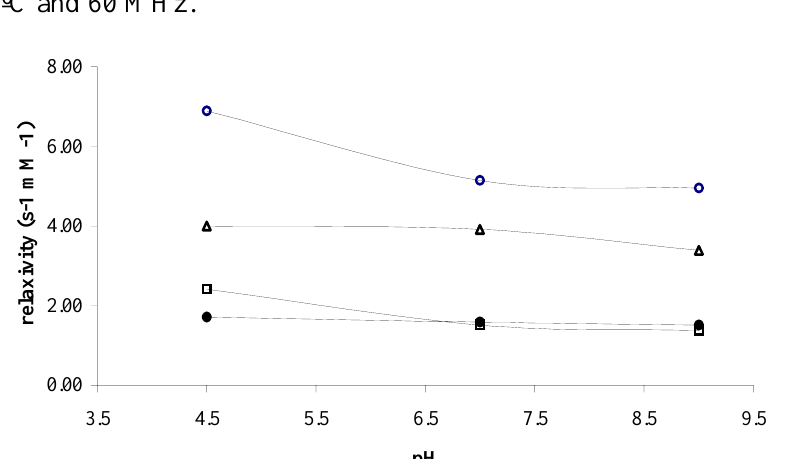
Figure 3. pH dependence of the proton longitudinal relaxivity of the water solution 1 mM of ) Gd(III)-1 , ) Gd(III)-dtpa , ) Gd(III)-2 , and ) Gd(III)-dota , at 37 ºC and 60